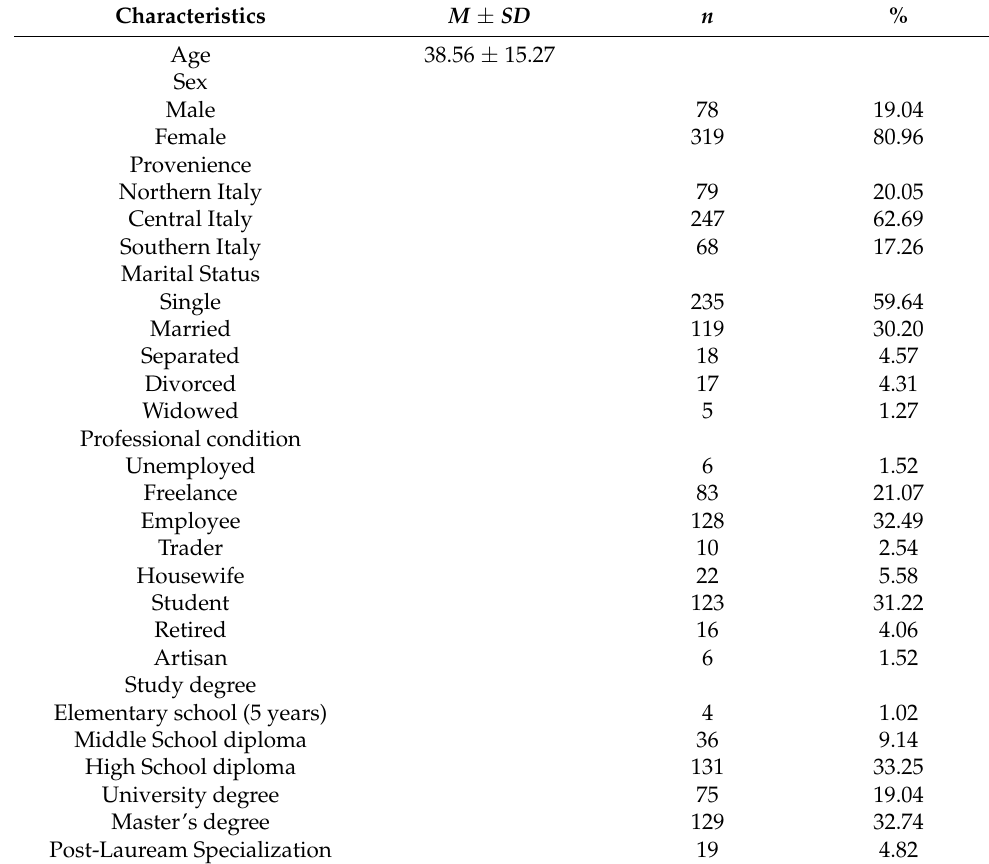
Table 1. Demographics variables of the sample ( n = 349).